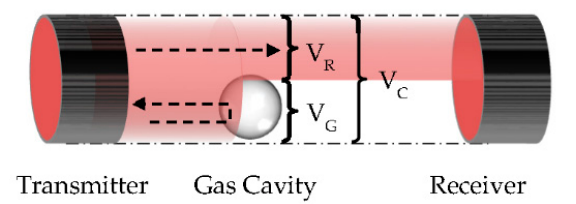
Figure 1. Simplified ultrasound trans-mission model with blocked transmission by gas